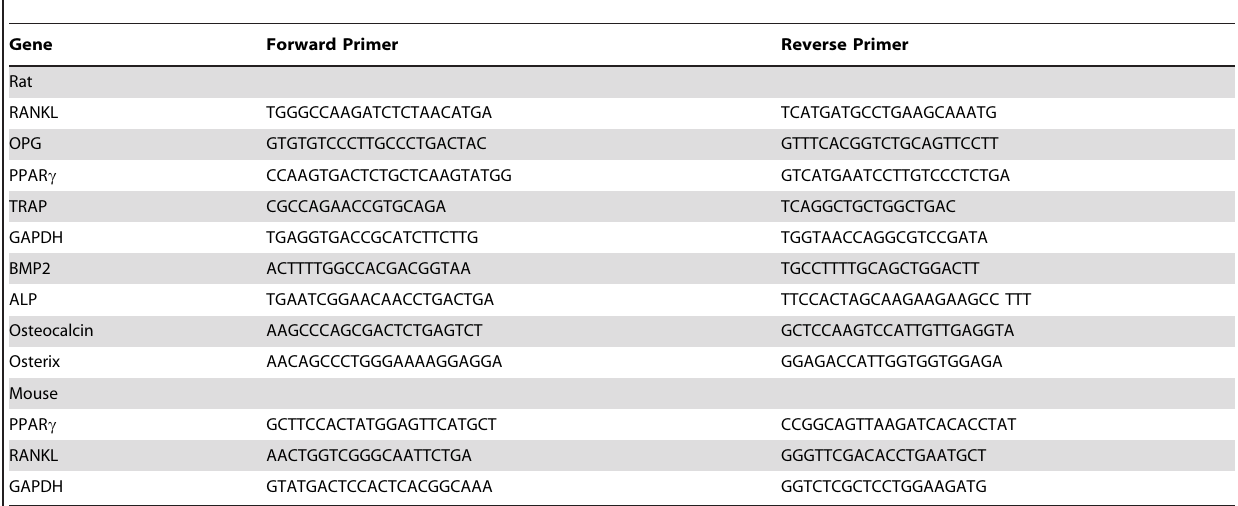
Table 2. Real-Time Reverse-Transcription Polymerase Chain Reaction (RT-PCR) Primer